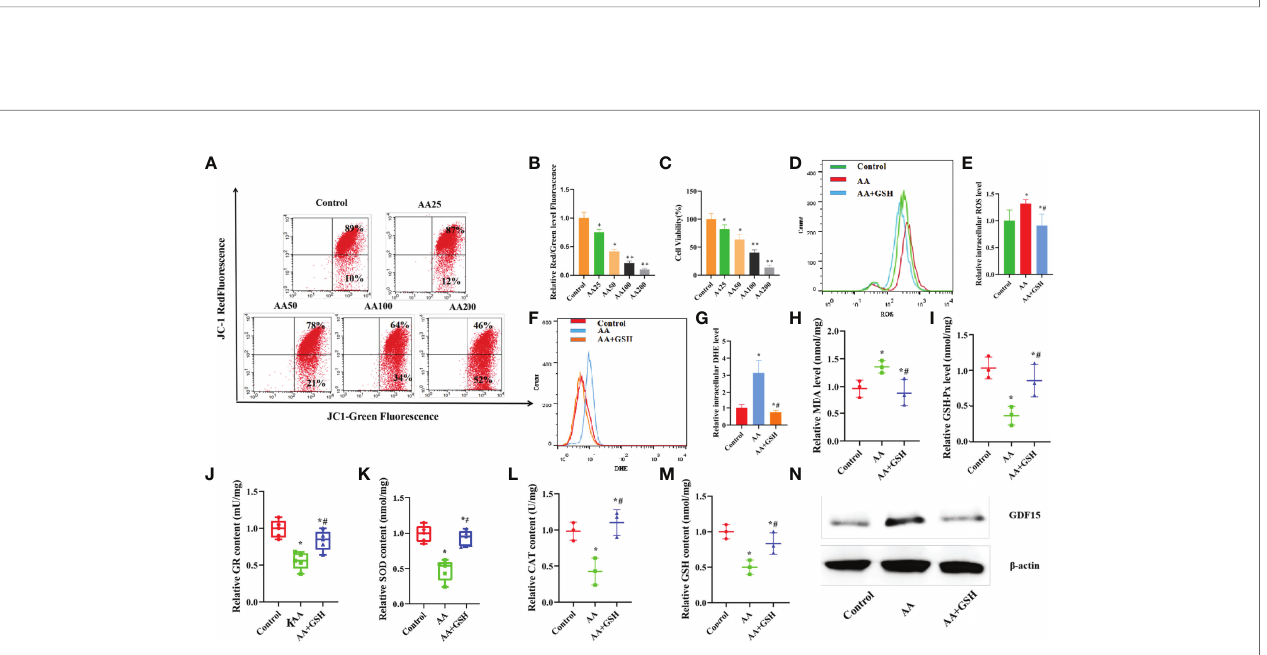
FIGURE 2 | (A – C) AA caused KGN cellstoxicity in a dose-dependent manner. (A, B) Mitochondrial membrane potential was decreasedwith increasing AA concentration. (C) The viability of KGN cellswas decreased with increasing AA concentration. (D – N) AA caused damageto antioxidant capability of KGN cells. (D,E) AA enhancedthe accumulation of the mitoSOX level. (F, G) AA enhanced the accumulation of theintracellular O 2- level. (H – M) AA weakened the activities of antioxidantenzymes SOD, CAT, GSH-Px andGR and the GSH content. (N) AA promoted the expression ofGDF15 protein.Data represent mean ± standard error,*P < 0.05, * # P <